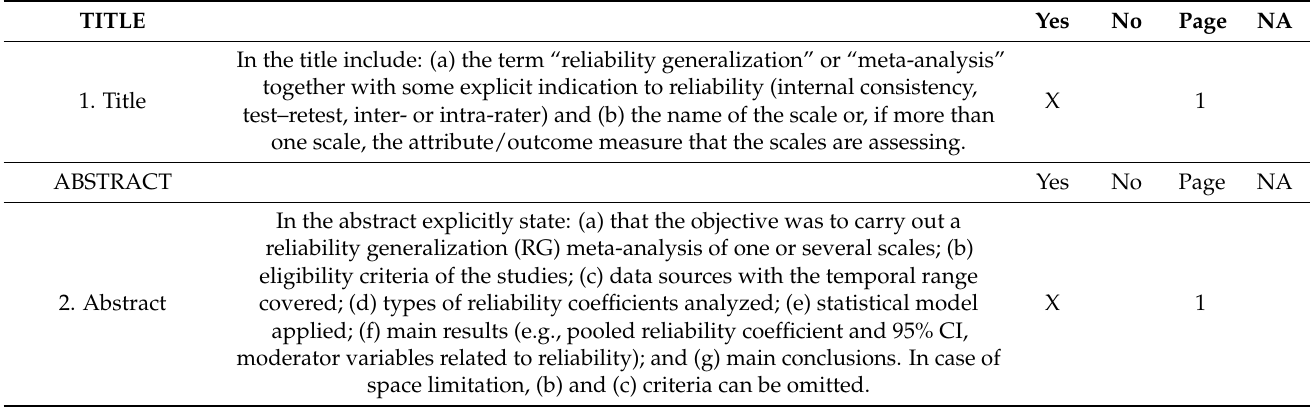
Table A1. Checklist for the corroboration of the meta-analytic report according to the